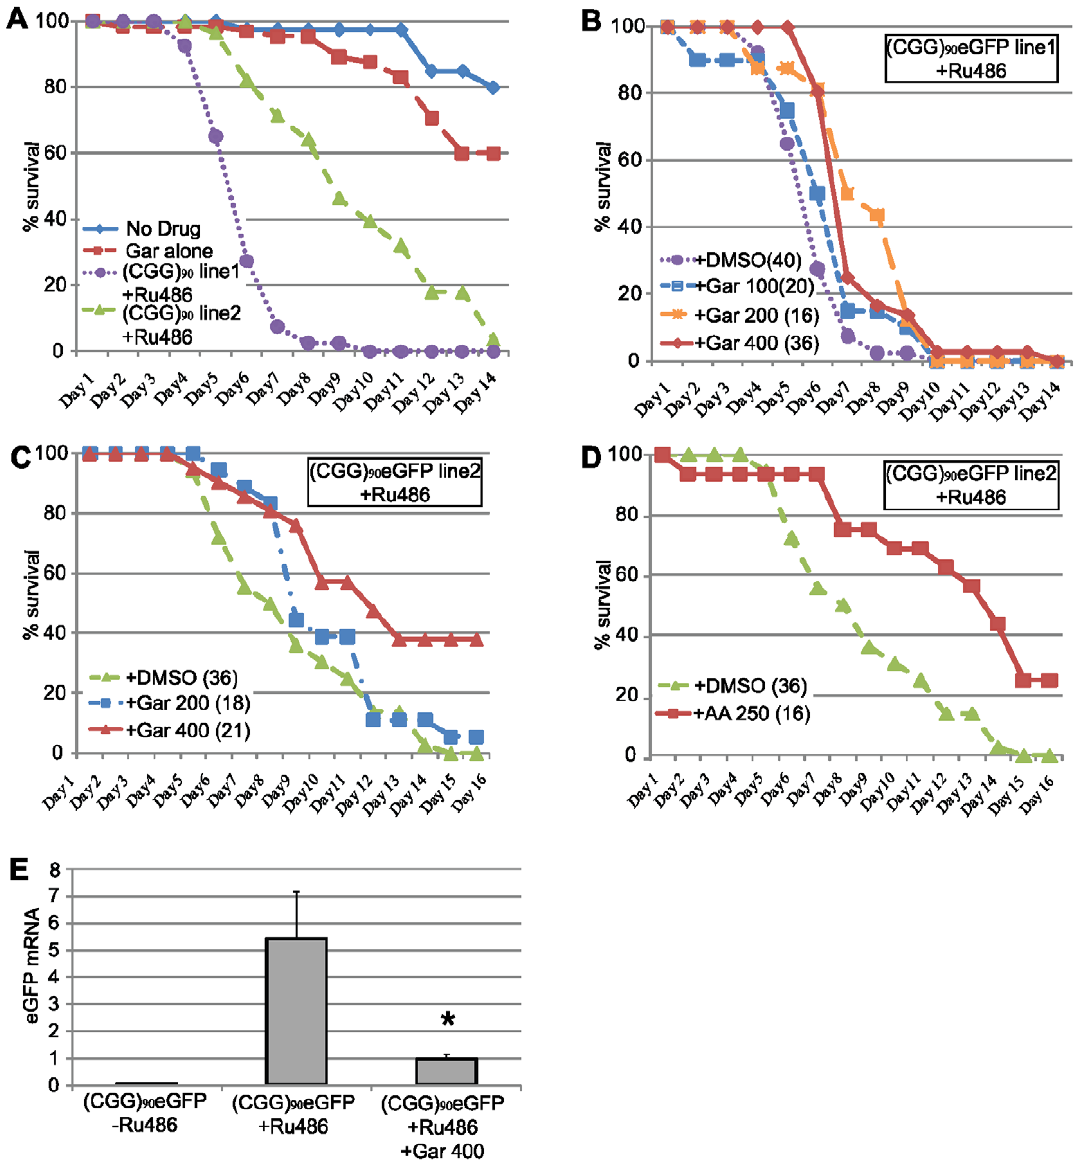
Figure 7. HAT inhibitors extend lifespan in adult (CGG) 90 -eGFP flies. A) young (1–3 days post eclosion) adult (CGG) 90 eGFP line 1or line 2 flies co-expressing a Tubulin Geneswitch driver were transferred to tubes containing normal fly food (blue line), food containing 400 m M Garcinol (red line), or food containing RU486 to activate expression of the ubiquitous driver (Line 1, purple line, Line 2 green line). Data is expressed as % survival over days and represents a summary of two independent experiments. B) For (CGG) 90 eGFP line 1, addition of Garcinol to the food containing RU486 led to a dose dependent increase in lifespan (purple= RU486 + DMSO, blue=RU486 + Gar 100 m M, orange=RU486 + Gar 200 m M, red=RU486 + Gar 400 m M, Log Rank test for trend, p , 0.0001). C) Similarly, for (CGG) 90 eGFP line 2, addition of Garcinol to the food containing RU486 led to a dose dependent increase in lifespan, with many flies at the highest dose surviving beyond the end of the study (green= RU486 + DMSO, blue=RU486 + Gar 200 m M, red=RU486 + Gar 400 m M, Log Rank test (Mantel-Cox), p , 0.0001). D) There was also a significant extension of lifespan with addition of Anacardic Acid (250 m M) to the food of (CGG) 90 eGFP line 2 flies (green= RU486 + DMSO, red=RU486 + AA 250 m M, Log Rank test (Mantel-Cox), p , 0.0001). E) (CGG) 90 eGFP mRNA expression was significantly induced after feeding the flies food containing RU486 for 72 hours. This RU486 activated (CGG) 90 eGFP mRNA expression was suppressed by co-treatment with 400 m M Garcinol (*=paired Students t-test, p , 0.01). Data presented are the summary of two independent experiments with n=10 flies per group for each study. (CGG) 90 eGFP mRNA is quantified in arbitrary units on the y axis. doi:10.1371/journal.pgen.1001240.g007 asymptomatic pre-mutation carrier lymphocytes and fibroblasts, the size of the expansion. Several lines of evidence suggest that this transformed lymphoblastoid cell lines, the brains of expanded elevated mRNA level is due to increased transcription, rather than CGG-FMR1 knock-in mouse models, and FXTAS patient brains altered stability, of FMR1 mRNA: 1) There are no changes in [5,10,11,48]. For repeat expansions in the pre-mutation range, the RNA stability as measured by the rate of decline of FMR1 mRNA degree of elevation in mRNA expression generally correlates with levels after treatment with the transcriptional inhibitor actinomy-